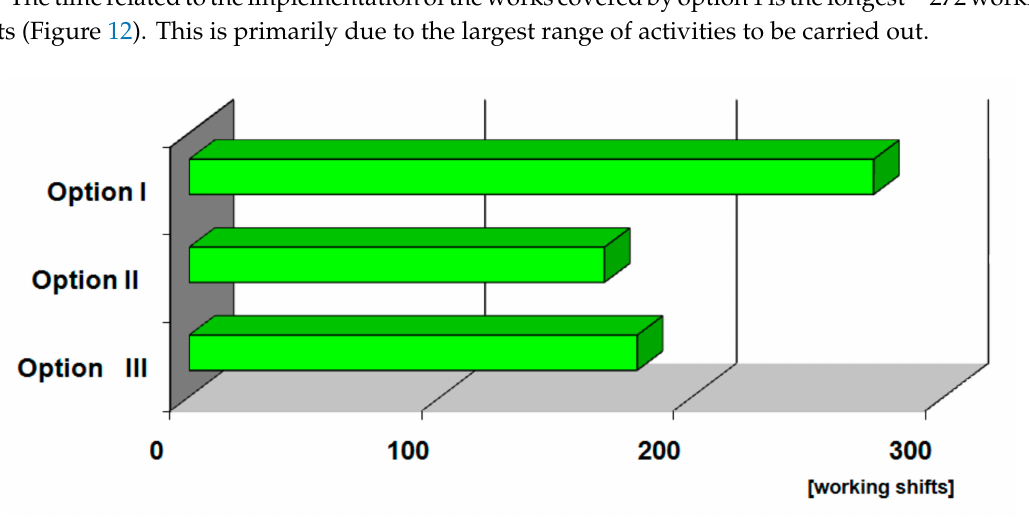
Figure 12. Duration of the works envisaged for implementation under options 1, 2,